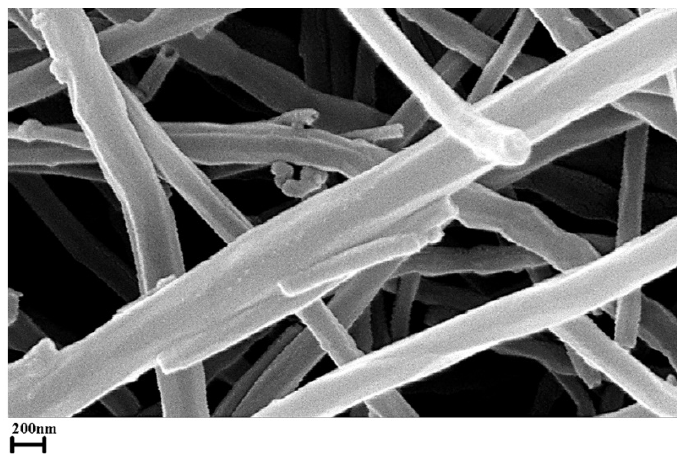
Figure 7. SEM image of the carbon nanofibers (CNFs).